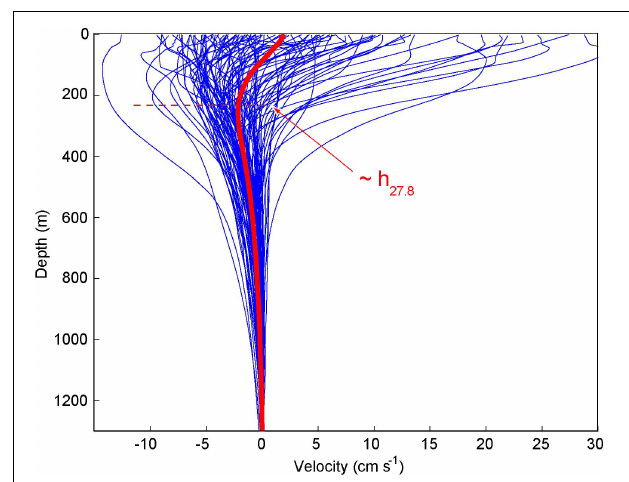
FIGURE 5 | Geostrophic eastward velocity calculations in the NSG rim (between standard stations N09 and N10), relative to z = 1300 m (deepest available data). The blue profiles represent individual occupations of Section N and the averaged of these is shown with the red profile. The average depth of the σ θ = 27.8 surface ( h 27 . 8 ) at this locations, is